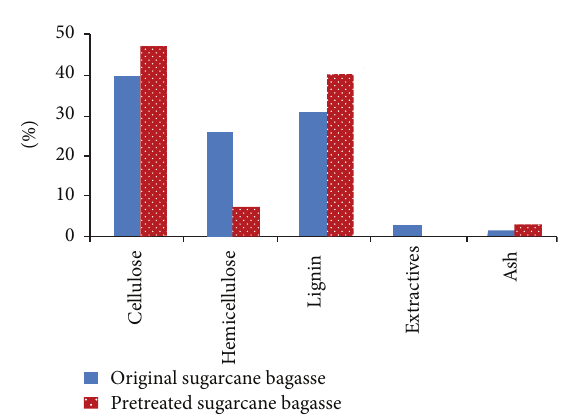
Figure 1: Composition profile (% dry weight) of original and dilute sulfuric acid pretreated sugarcane bagasse (diluted H 2 SO 4 98%, 20 minutes at 121 ∘